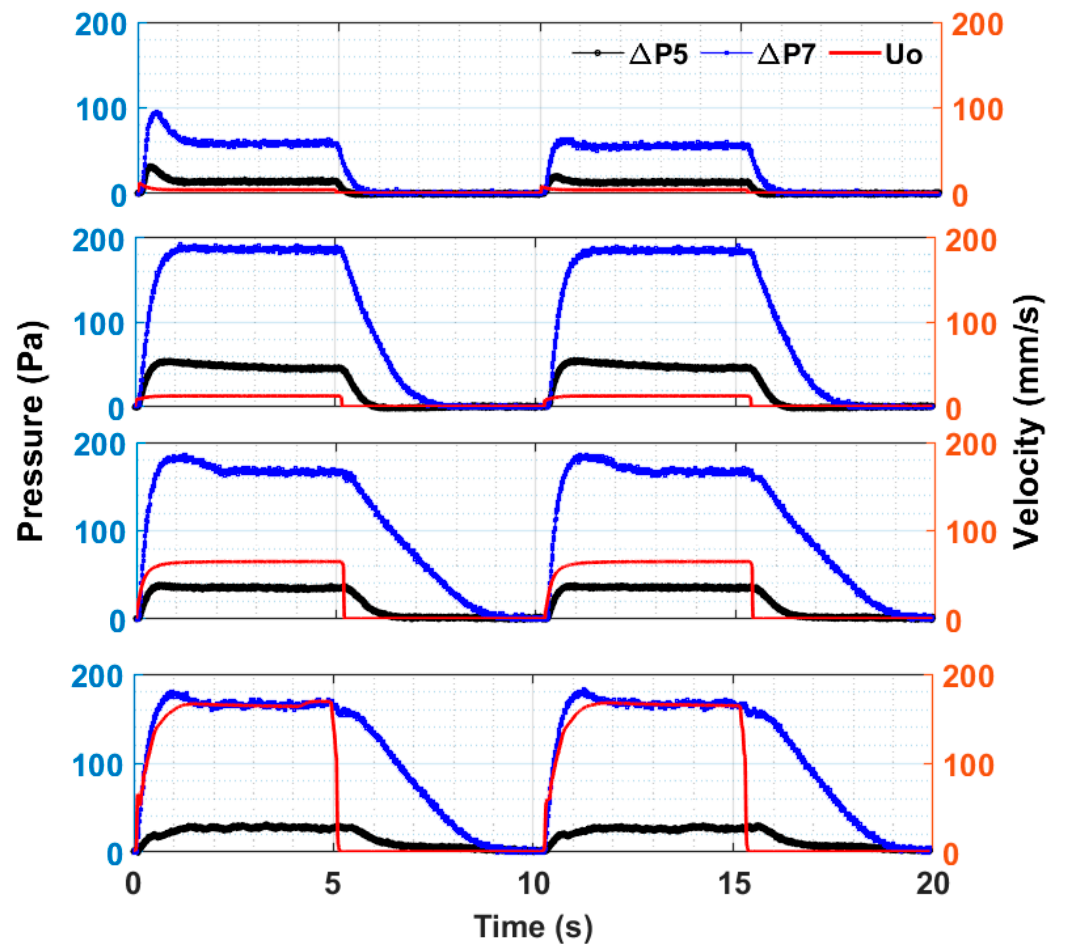
Figure 7. Overall ( ∆ P 7 ) and lower region ( ∆ P 5 ) pressure transients for U o = 4 mm / s, 12 mm / s, 65 mm / s, and 165 mm/s in pulsed fluidized beds.